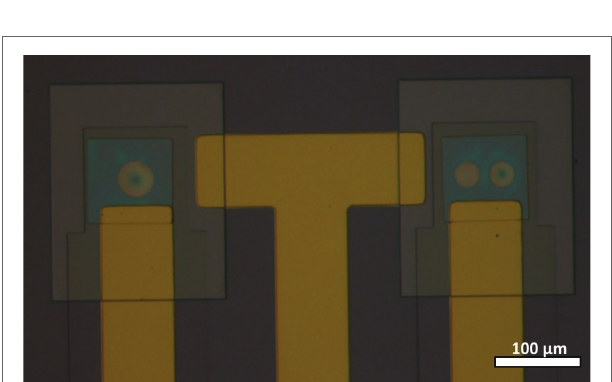
FigUre 3 | Optical microscope image of fabricated nanoplate resonators . The active device is the one shown on the right-hand side, displaying double cavities with r = 14 μ m. The device shown on the left-hand side with r = 20 μ m is used as a reference for the capacitive measurement.